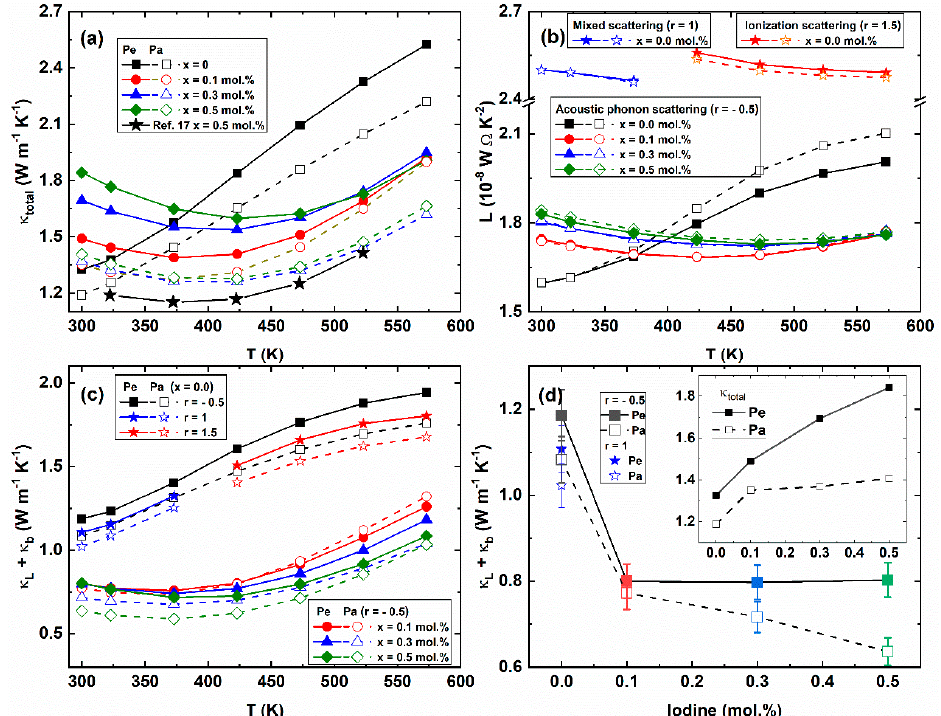
Figure 4. Temperature-dependent total thermal conductivity κ total (T) ; ( a ) calculated Lorenz number L(T) ; ( b ) combined lattice and bipolar thermal conductivity κ L + κ b of the Bi 2 Te 2.85 Se 0.15 I x (x = 0.0, 0.1, 0.3, 0.5 mol.%) compounds; ( c ) Combined lattice and bipolar thermal conductivity as a function of I-doping concentration at 300 K for the Pe-direction (closed symbol, solid line) and Pa-direction (open symbol, dashed line); ( d ) Inset of (d) shows the total thermal conductivity as a function of I-doping concentration.